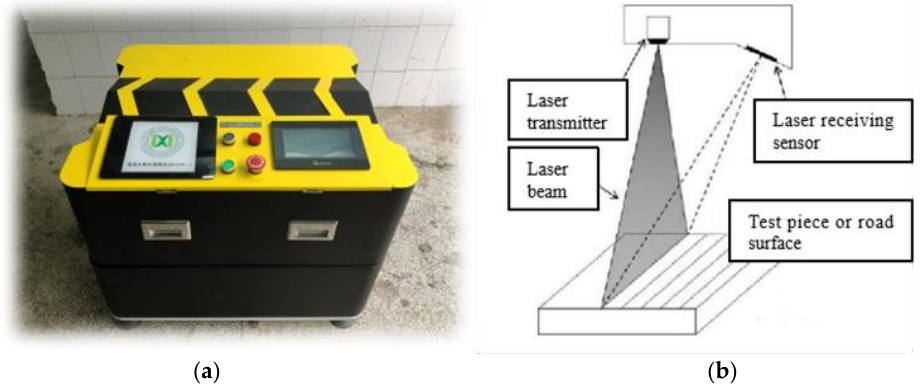
Figure 11. Pavement anti-skid texture tester: ( a ) Laser texture meter ( b ) Schematic diagram of scanning principle. Table 5. Results for FAC-10 laser texture detection.